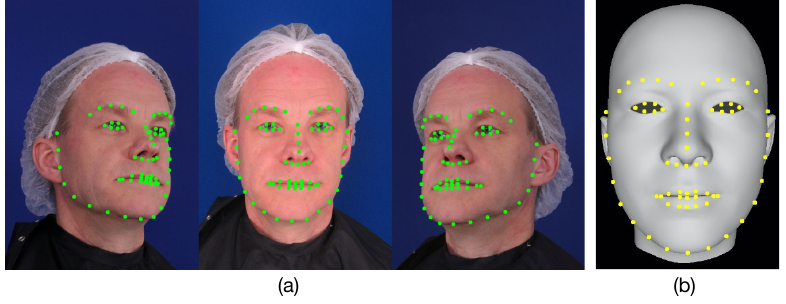
Figure 2. ( a ) The extracted feature pixels (green pixels) in the left, center and right viewpoints. ( b ) The initial average 3D face mesh and its corresponding landmarks (yellow points) located